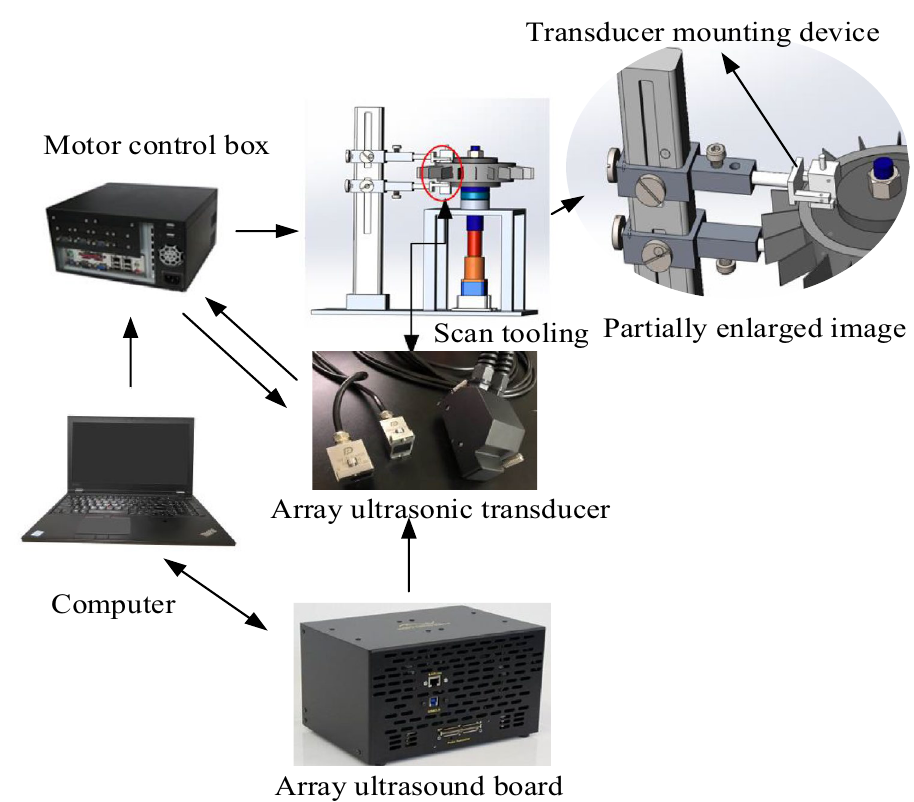
Figure 15. Automatic ultrasonic array testing system for superalloy